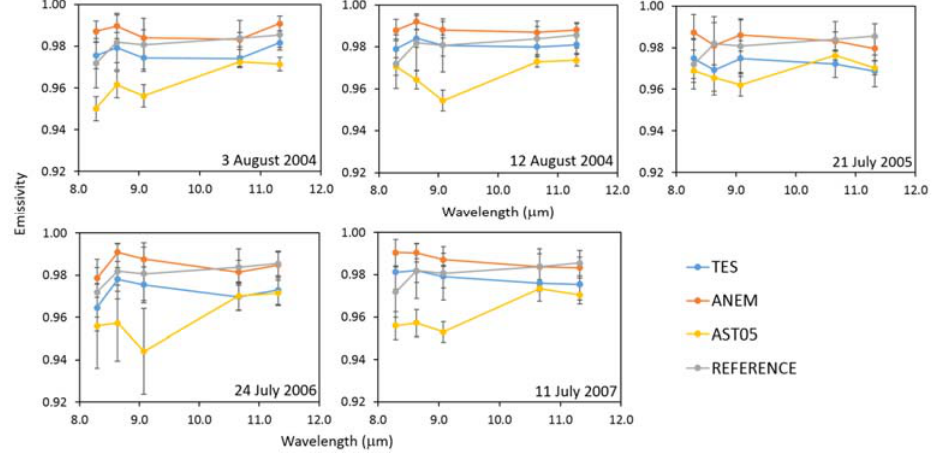
Figure 3. Rice crop emissivity for each studied day measured in the field (REFERENCE), obtained with TES and ANEM methods, and provided by the standard product AST05.